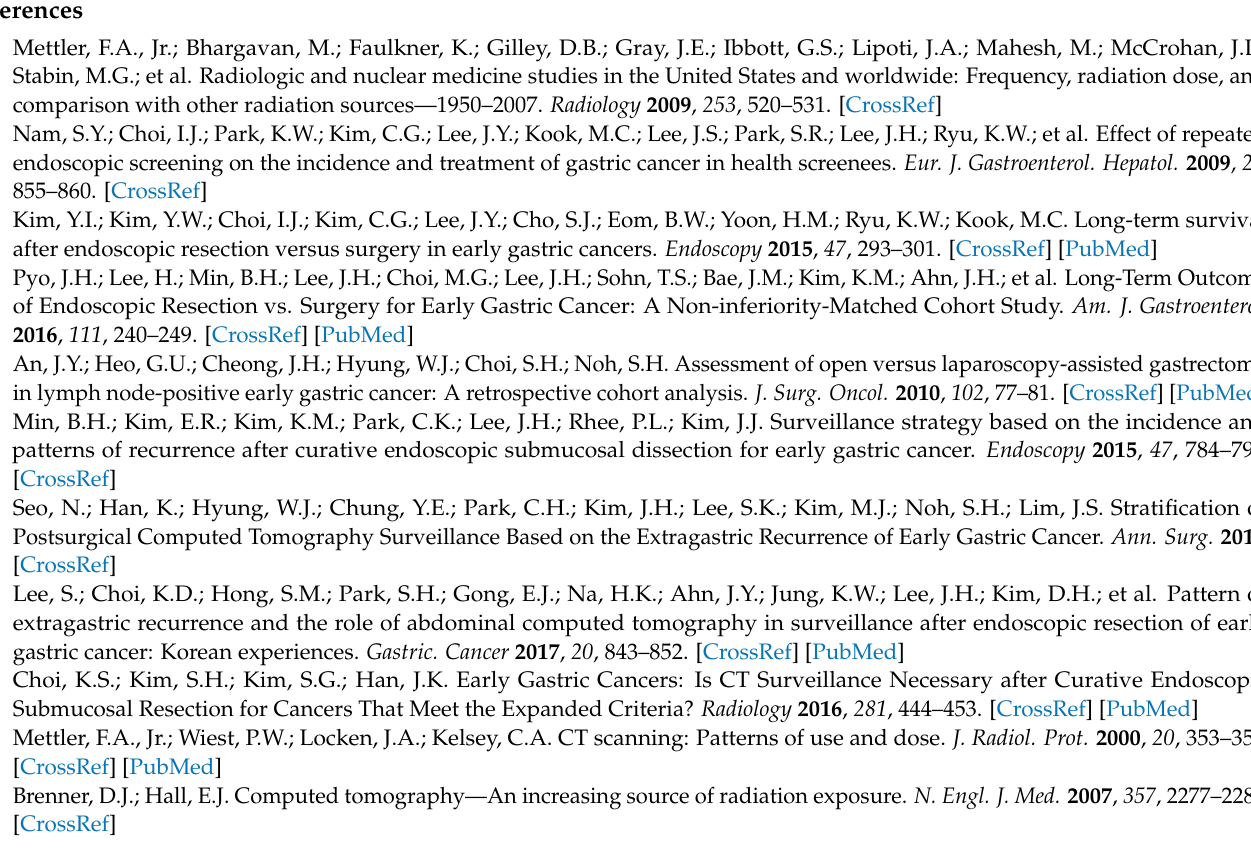
Table S3. Risk of intra-abdominal SPMs following abdominopelvic CT scans in selected population subgroups; Figure S1. Absolute risks for SPMs according to the number of CT